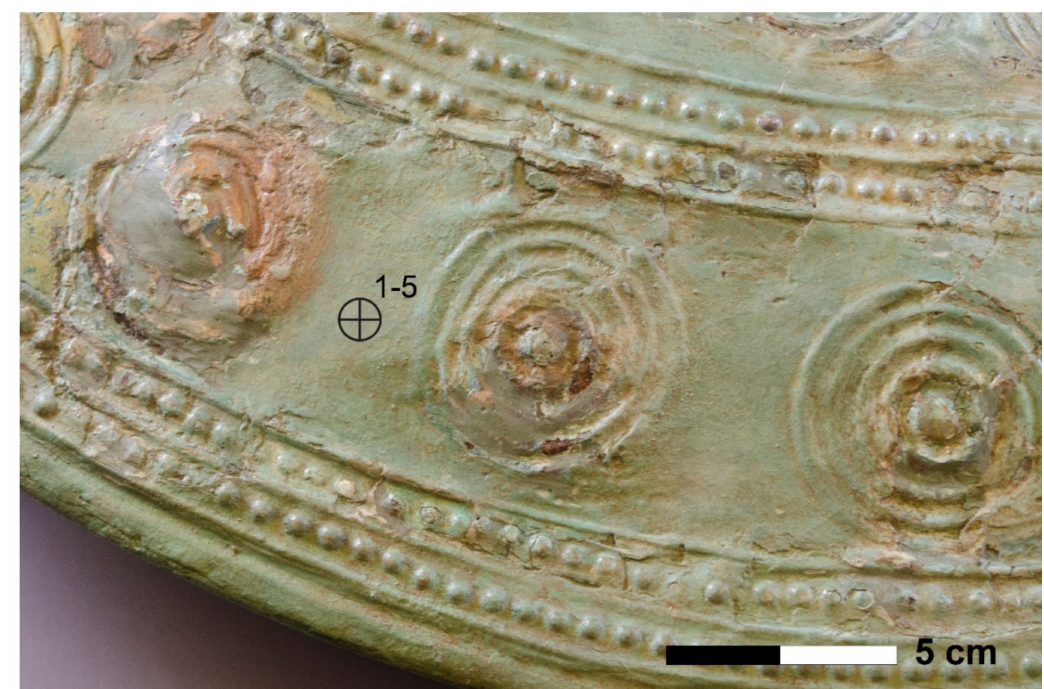
Figure 5. Detail photograph of the cluster assay location on VG013 (shield from Veii, Casale del Fosso, tomb